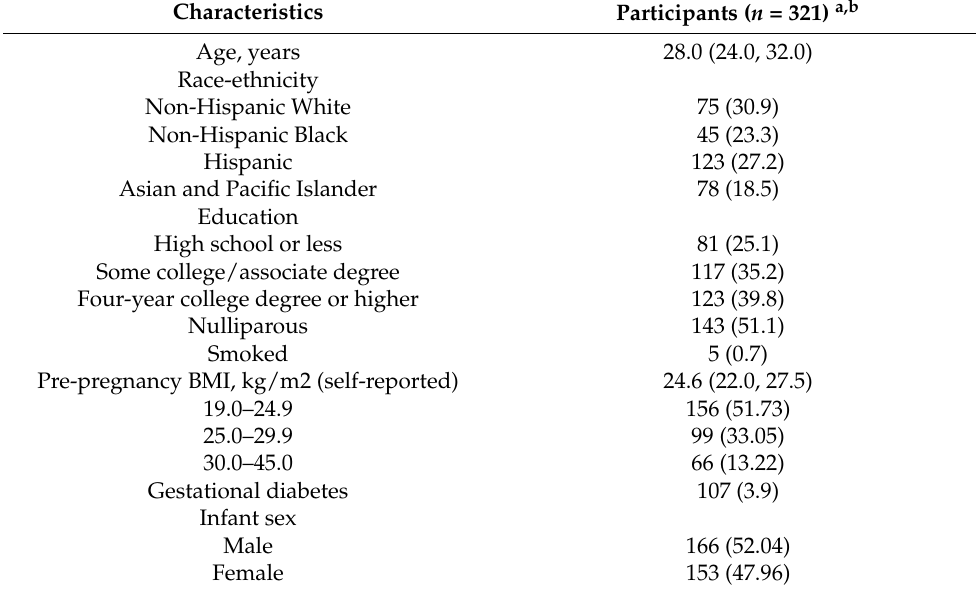
Table 1. Baseline characteristics of study participants with GDM and their age- and race-matched controls in the NICHD Fetal Growth Studies-Singleton